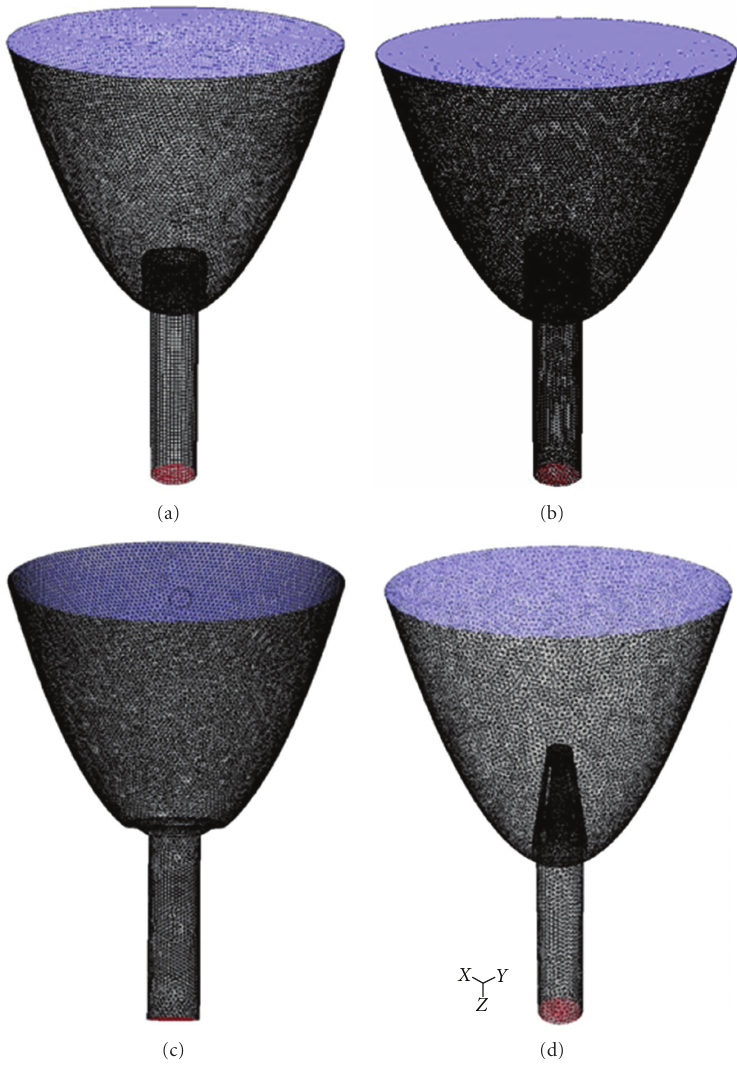
Figure 3: Numerical models of inflow cannulas insertion: (a) blunt, (b) beveled, (c) trumpet, and (d)